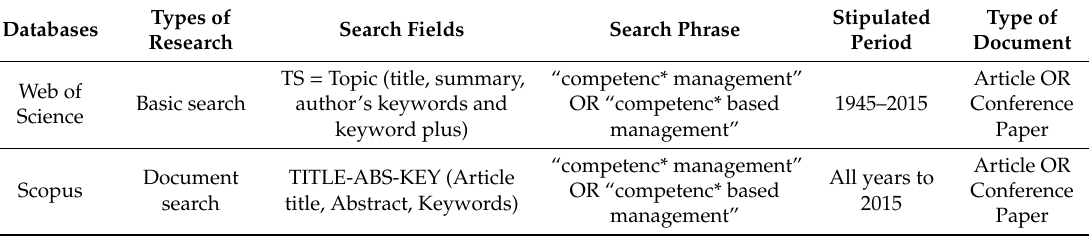
Table 1. Strategies for the identification of papers about competence-based management.